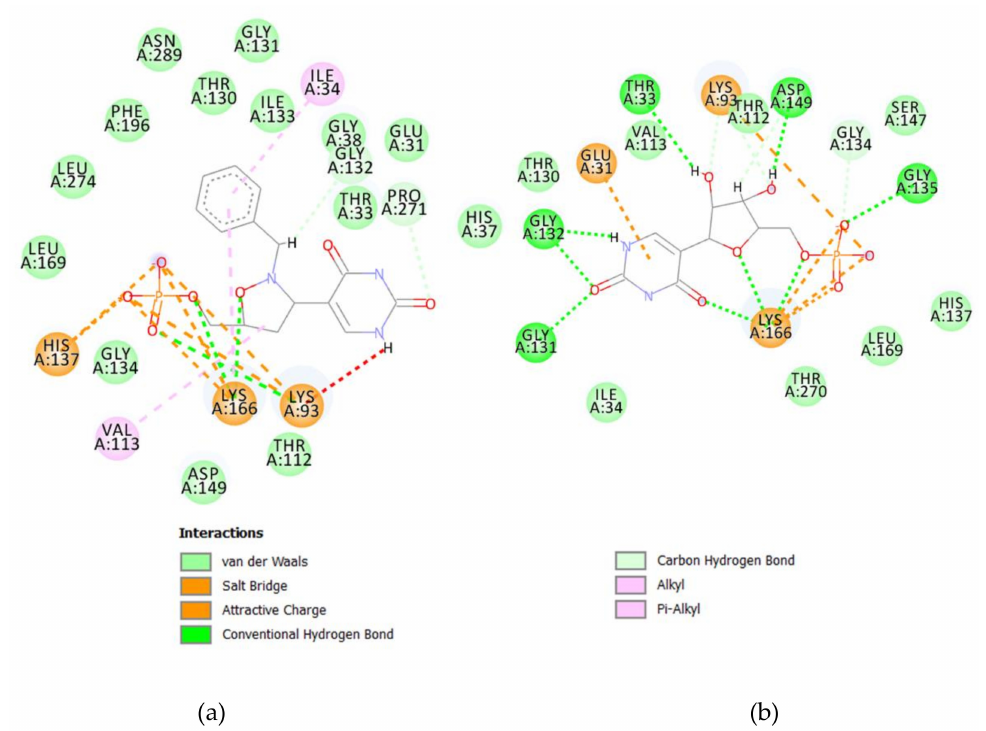
Figure 3. 2D molecular interaction of 3 5 (cid:48) -P ( a ) and Ψ ( b ) with Ψ 5 (cid:48) -P